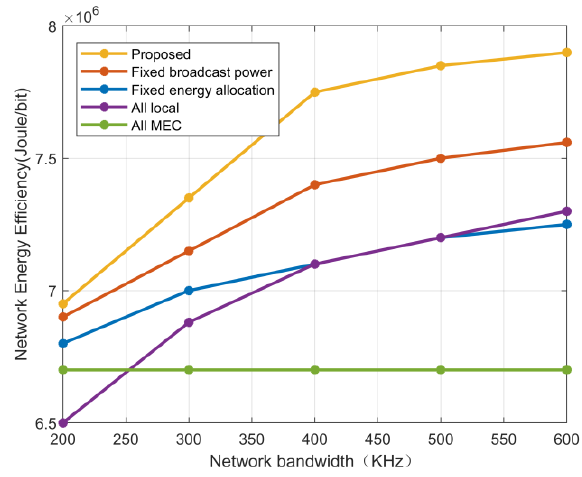
Figure 4. The performance of energy efficiency under different algorithms with network bandwidth.